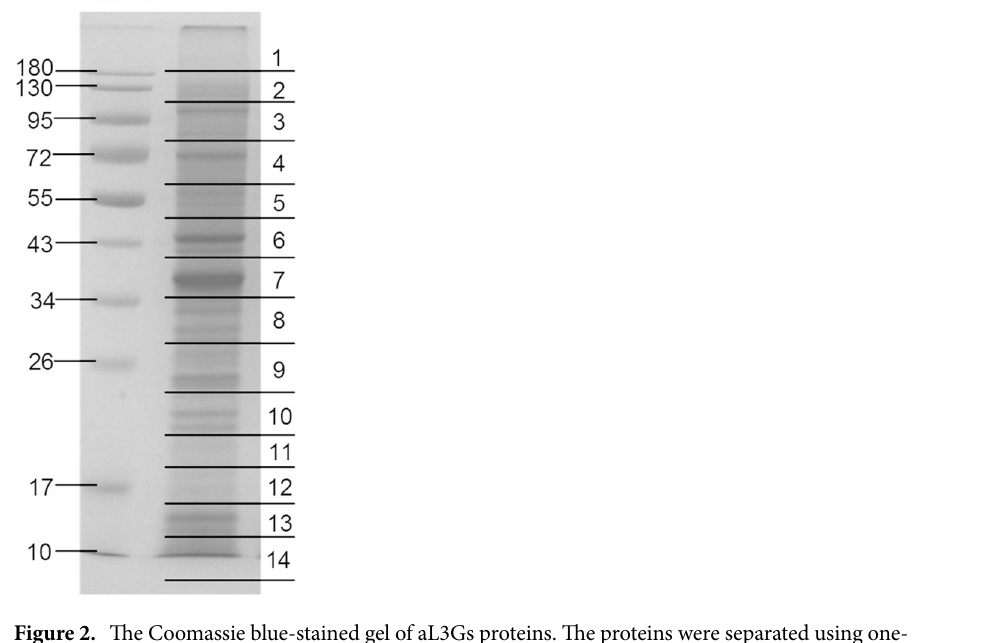
Figure 2. The Coomassie blue-stained gel of aL3Gs proteins. The proteins were separated using one- dimensional gel electrophoresis.